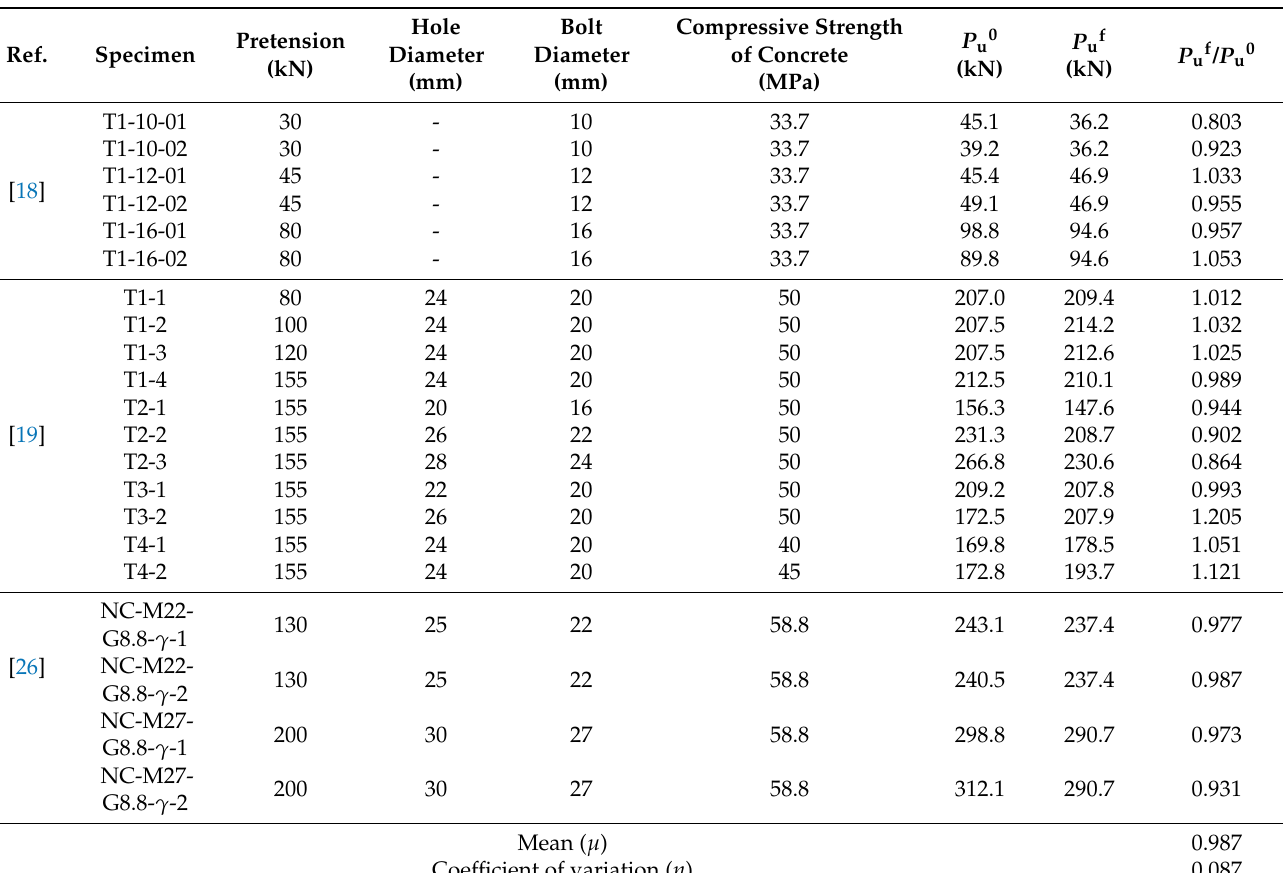
Table 1. Comparison of the shear resistance obtained from FE results and